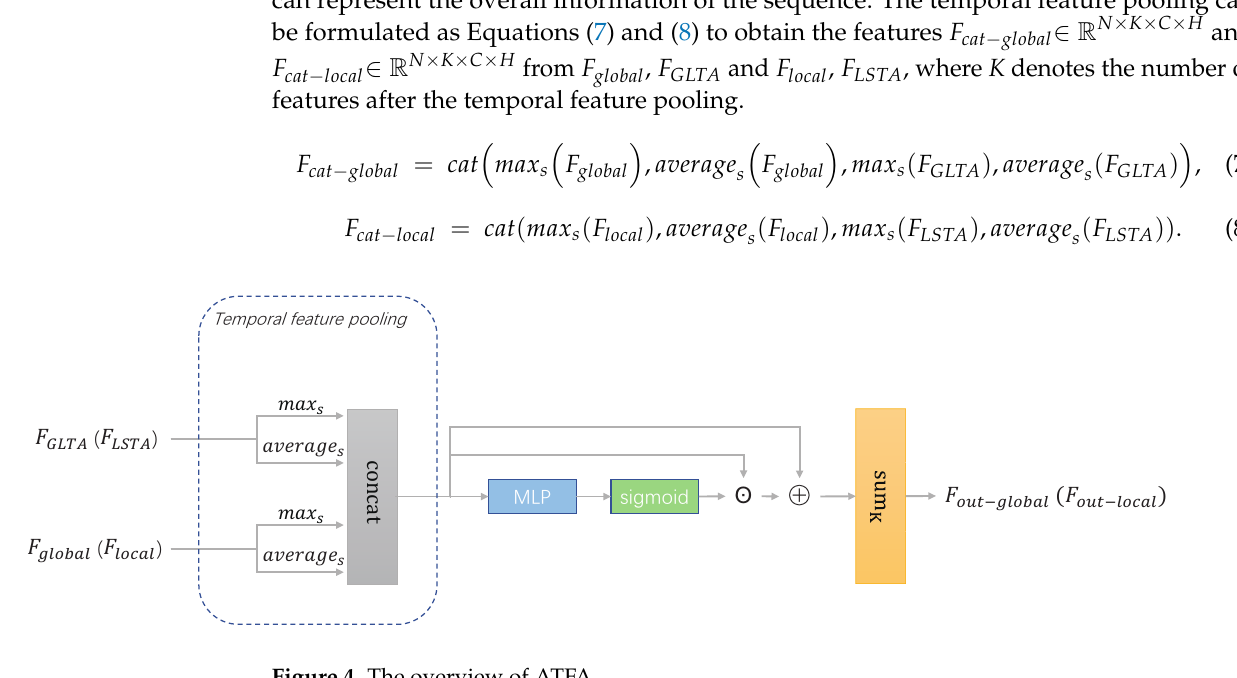
Figure 4. The overview of